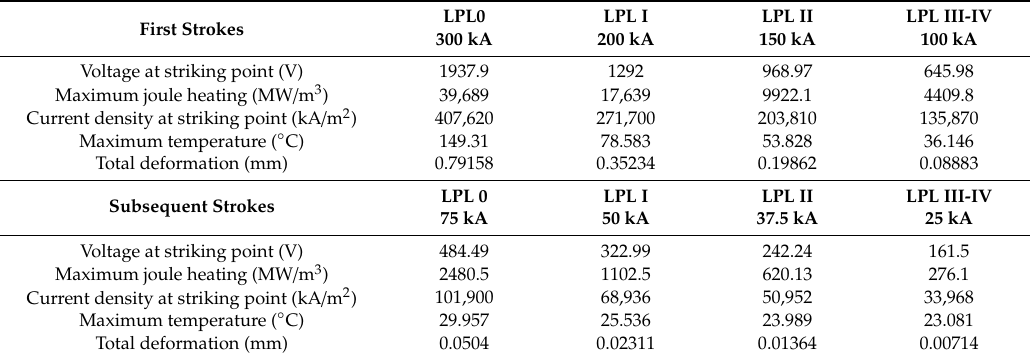
Table 3. Results obtained from the first and subsequent return for Case Study